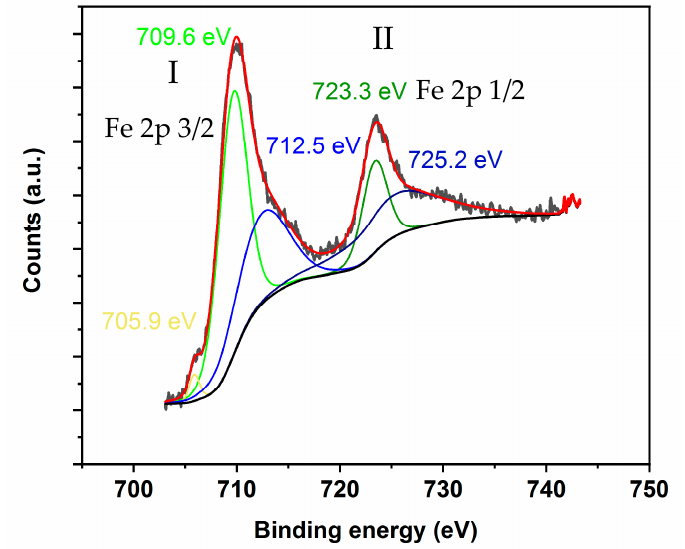
Figure 8. Figure 8. Fitted XPS spectrum for the Fe x O y /CaO- γ -Al 2 O 3 catalyst, partially reduced at 650 °C: 650 ◦ C: Fe 2p 1 / 2 and Fe 2p 3 / 2 peaks; Shirley background; G.L.(Gaussian / Lorentzian formula) = 70; Fe 2p ½ and Fe 2p 3/2 peaks; Shirley background; G.L.(Gaussian/Lorentzian formula) = 70; 𝜒 (cid:2870) χ 2 = = 1.54 ).